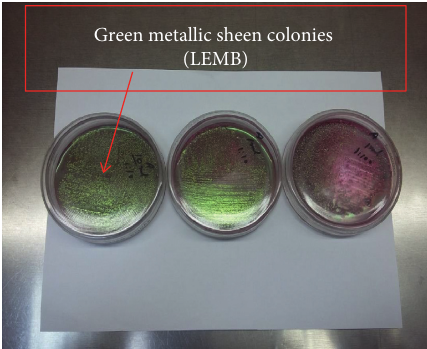
Figure 4: Growth of Escherichia coli on LEMB agar medium (green metallic